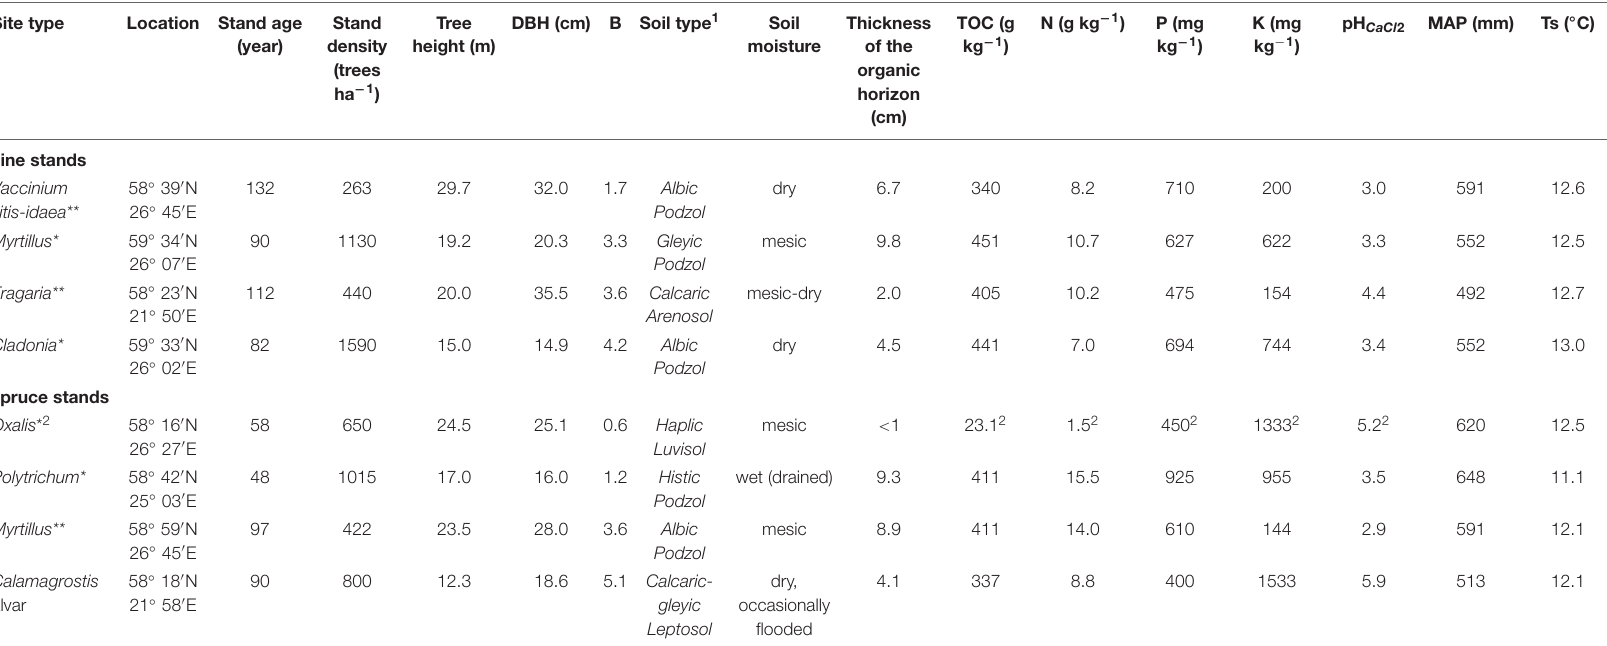
TABLE 1 | Site characteristics and the chemical parameters of the soil organic layer (TOC, N, P, K, and pH) of the studied Scots pine and Norway spruce stands (Kriiska et al., 2019). Site